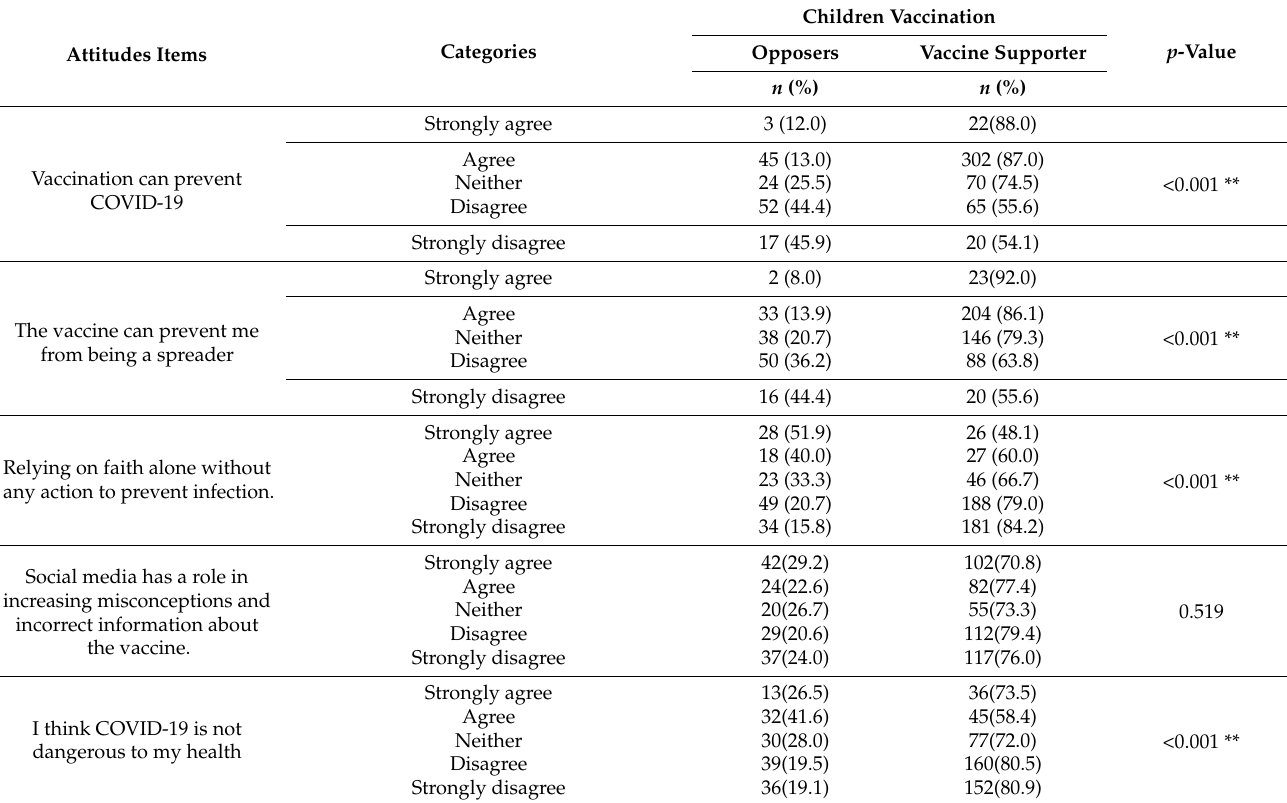
Table 5. Participants’ attitudes, beliefs, and emotions towards COVID-19 vaccination among children.